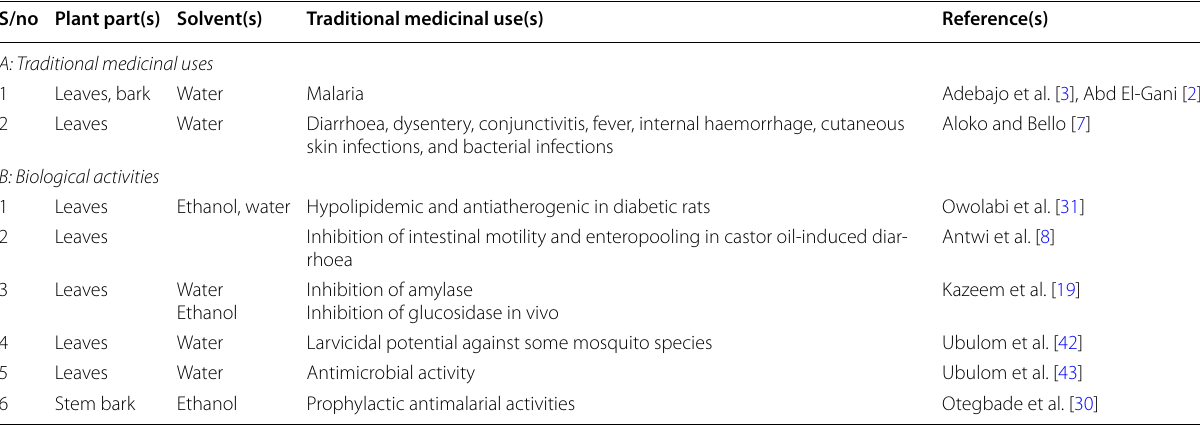
Table 1 Traditional uses and biological activities of B. sapida S/no Plant part(s) Solvent(s)